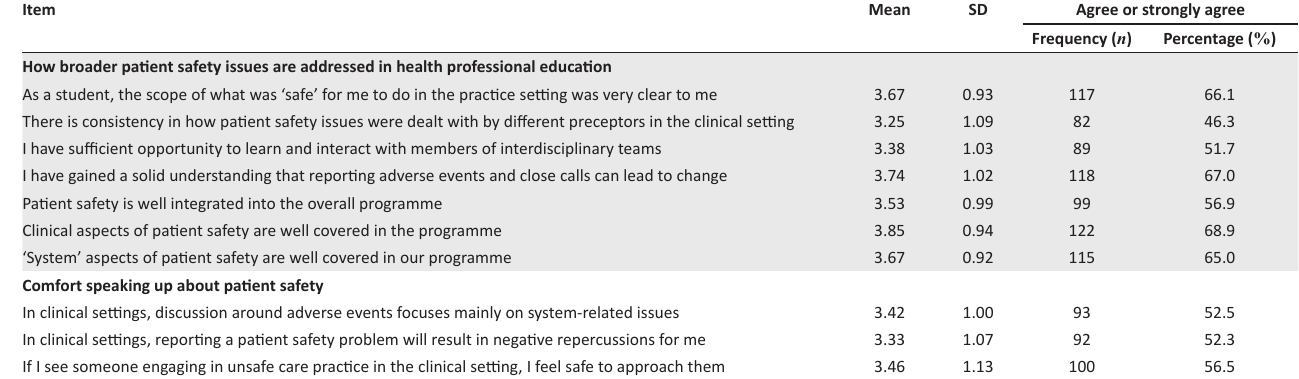
TABLE 4: Broader aspects of patient safety and comfort in speaking up about patient safety. Item Mean SD Agree or strongly